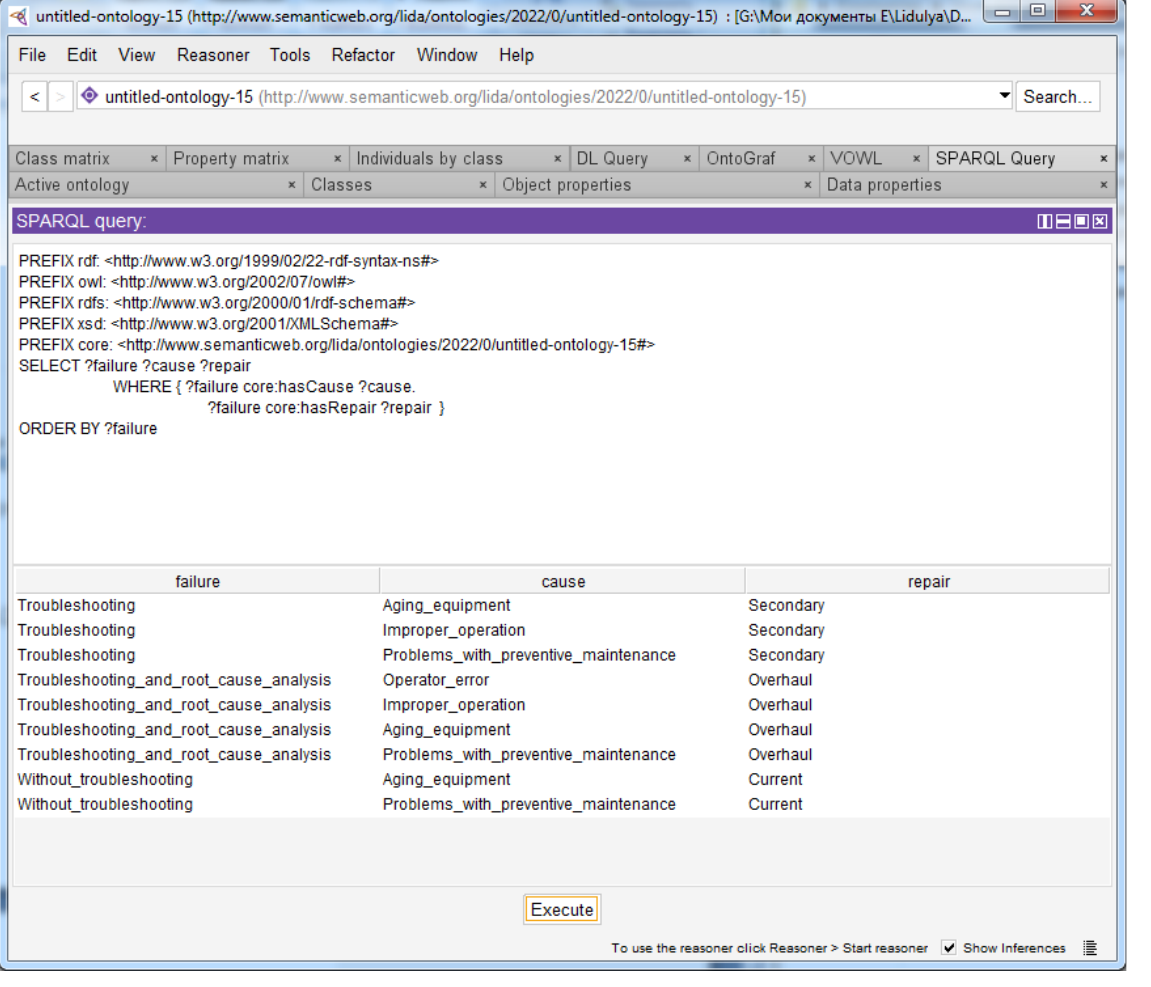
Figure 7. Query 3.